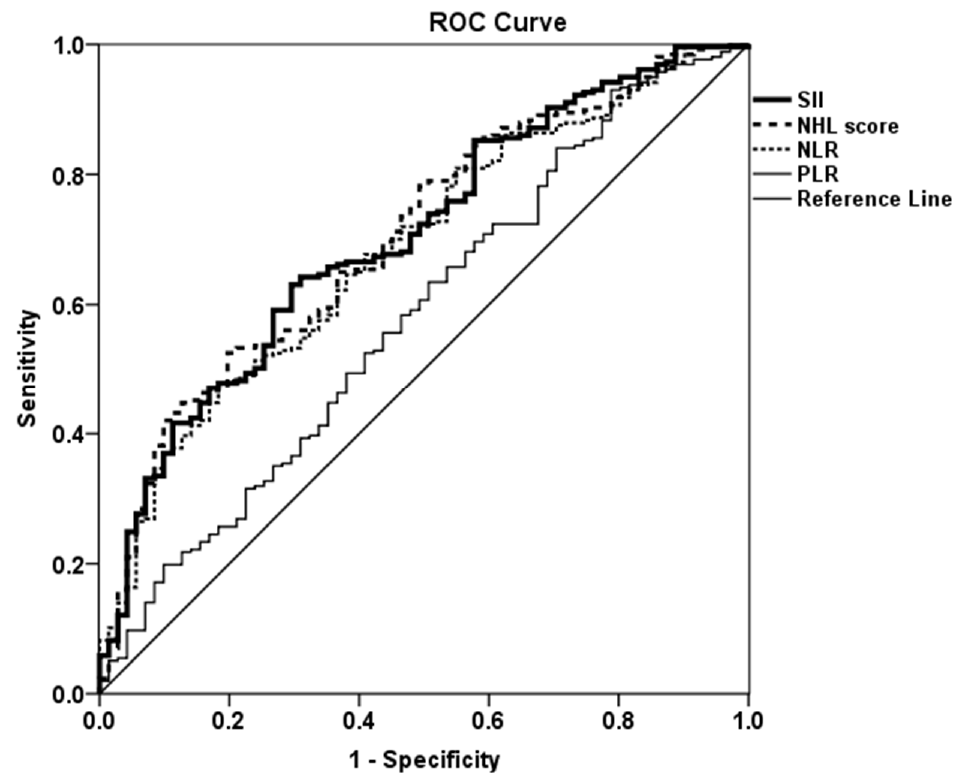
Figure 1. Receiver operating characteristic curve analysis of hematological indices in the diagnosis of RA. Abbreviation: SII, systemic immune-inflammation index; NHL, neutrophil-to-hemoglobin and lymphocyte; NLR, neutrophil-to-lymphocyte ratio; PLR, platelet-to-lymphocyte ratio. Table 5. Analysis by receiver operating characteristic curve of hematological indices and acute phase reactants for